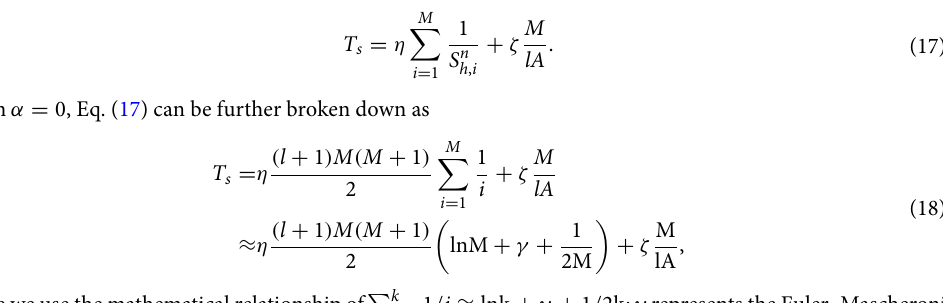
0 . The dashed lines rep- =